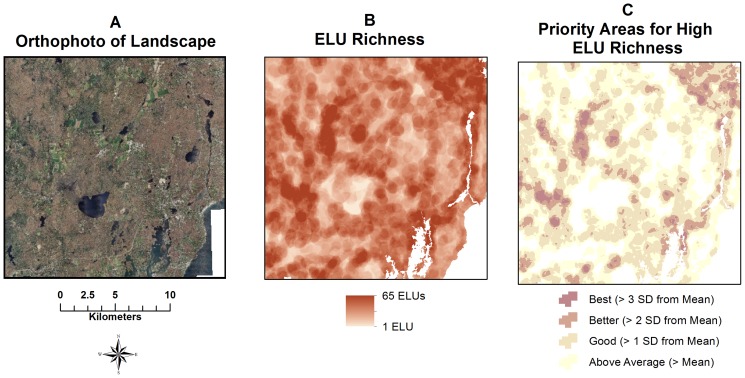
Spatial pattern of ELU richness.(A) Rhode Island landscape, 2011 digital orthophoto. Area mapped same as Figure 2. (B) Number of ELU types within a 30 pixel (457 m) radius. (C) ELU categories based on standard deviation units from the statewide mean variety ( = 24 ELU types in a 30 pixel radius). Basemap data from Environmental Systems Research Institute (Redlands, CA), and Rhode Island Geographic Information System database.